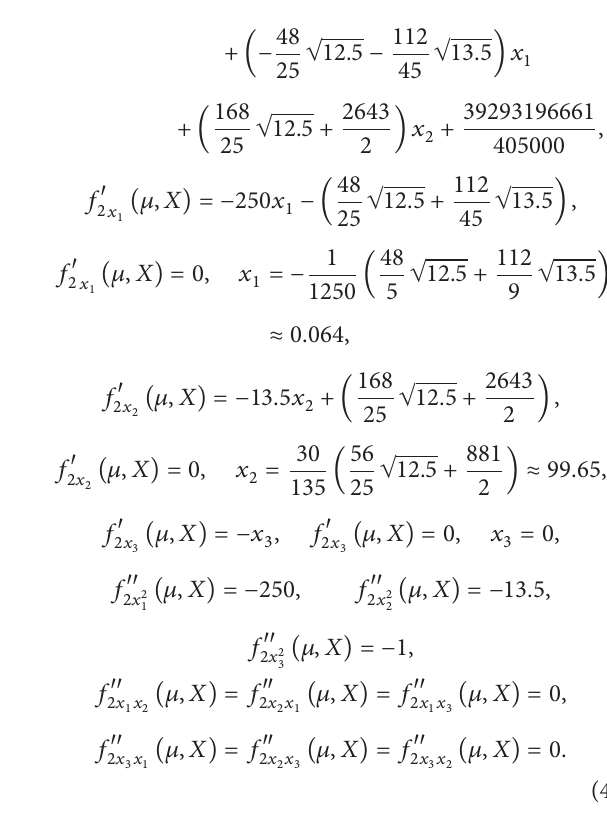
Figure 4: Simulation of system (45).